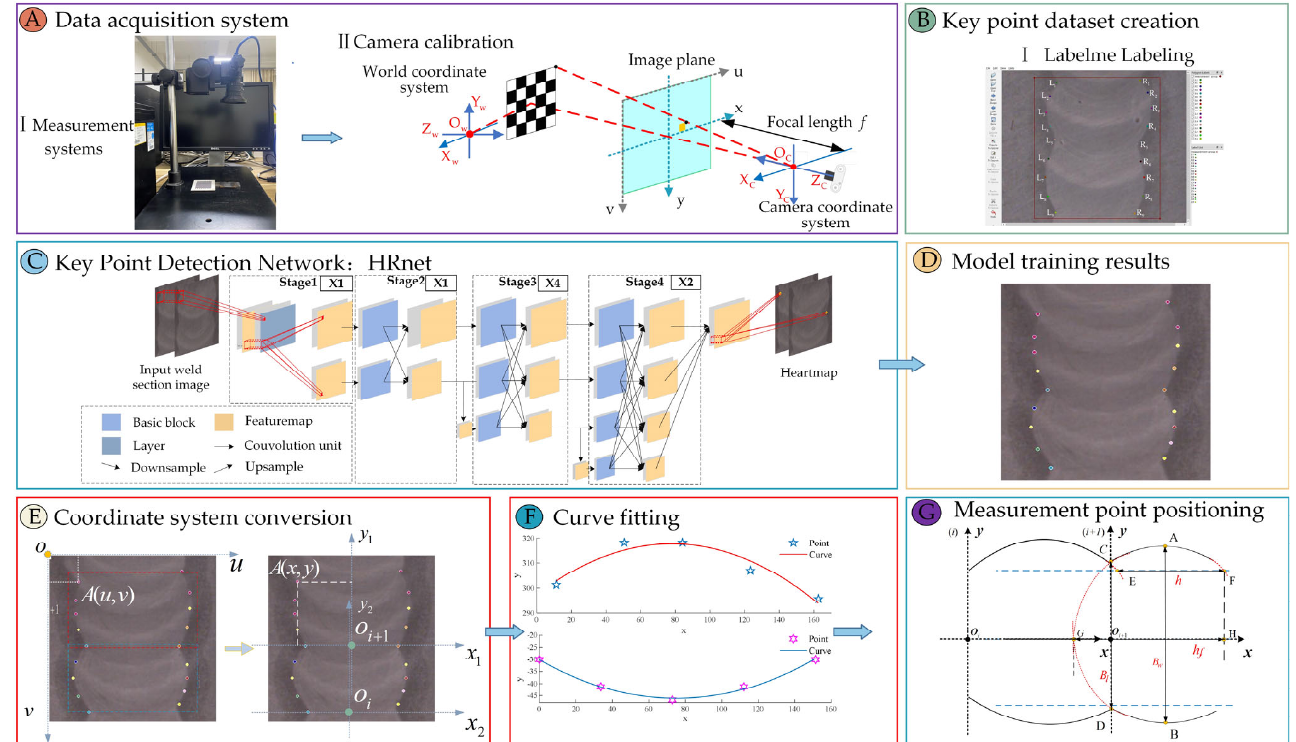
Figure 4. Flow chart of weld cross ‐ section shape detection.